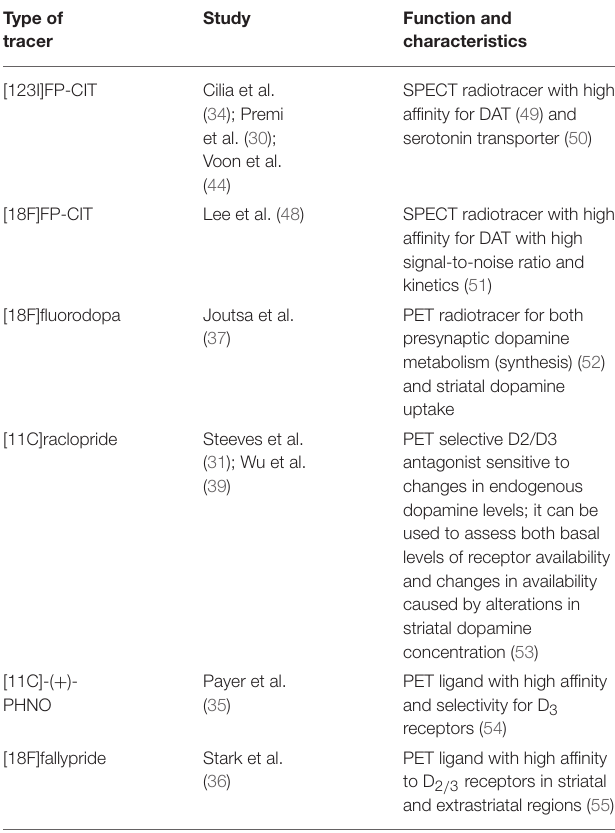
TABLE 3 | Radiotracers used in studies included in the